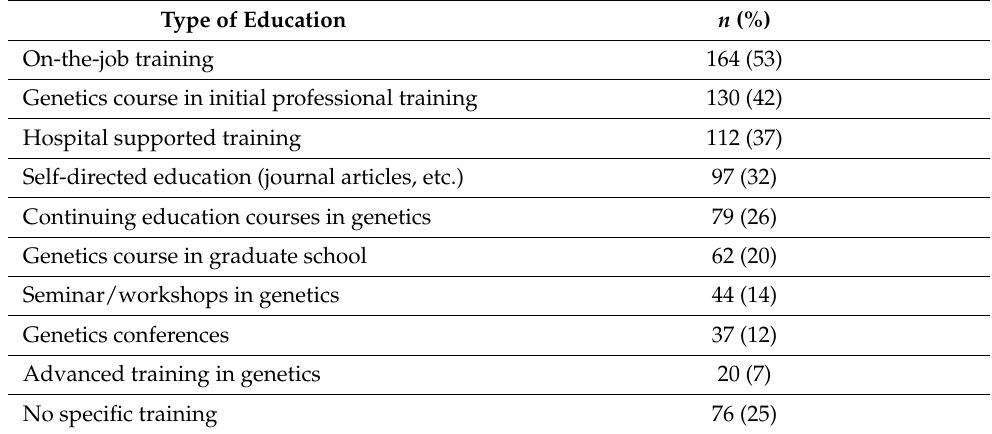
Table 2. Genetics or genomics education of